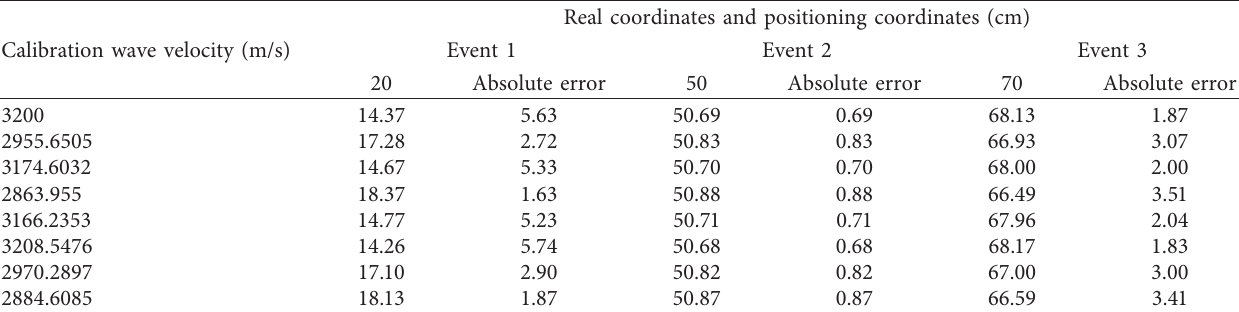
Table 6: The real coordinates and positioning coordinates of line positioning at different wave velocities in